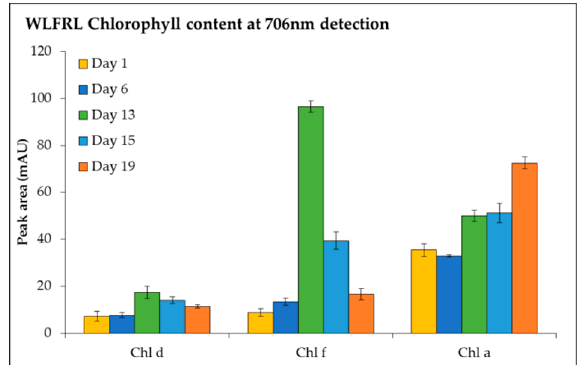
Figure 6. Chlorophyll content (chl d , chl f , and chl a , detected at 706 nm) of C. fritschii exposed to LED white light supplemented with far-red light conditions (WLFRL) at day 1, 6, 13, 15, and 19.